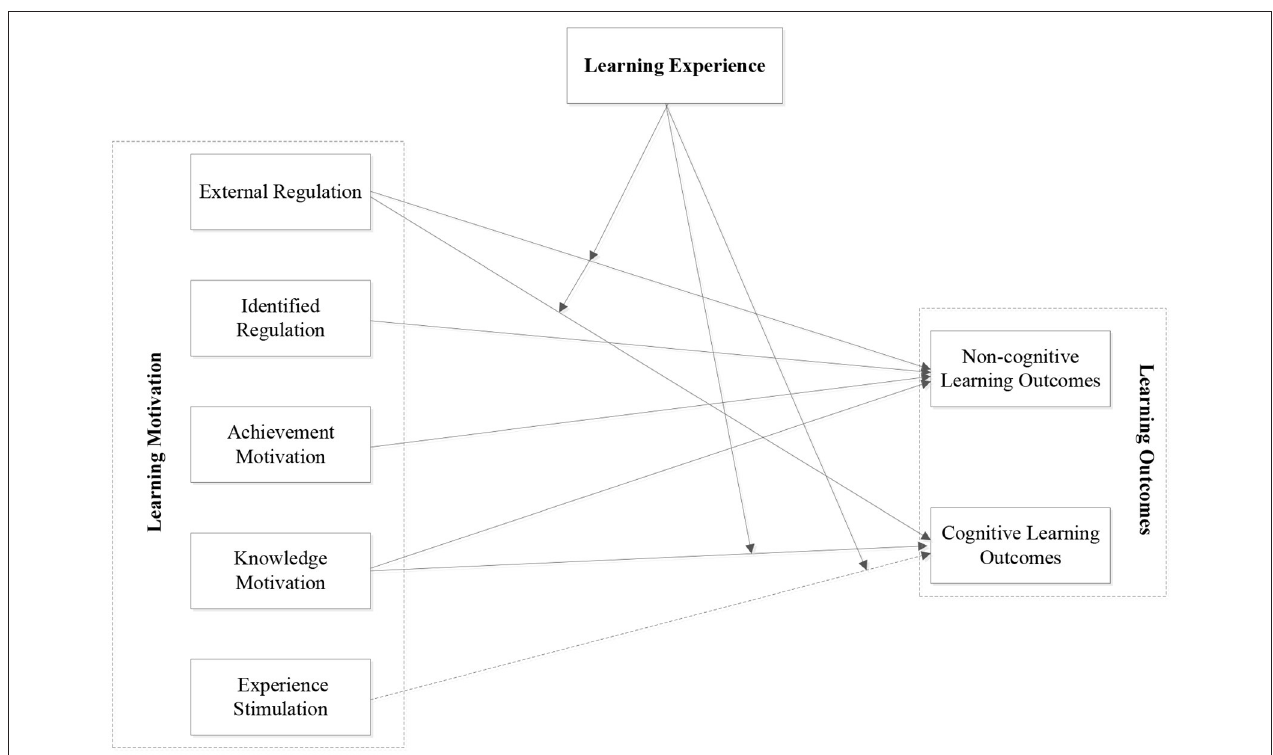
FIGURE 2 | Final MEO model. The solid lines indicates significant relationships between variables, while the broken line represents that the relationship is not